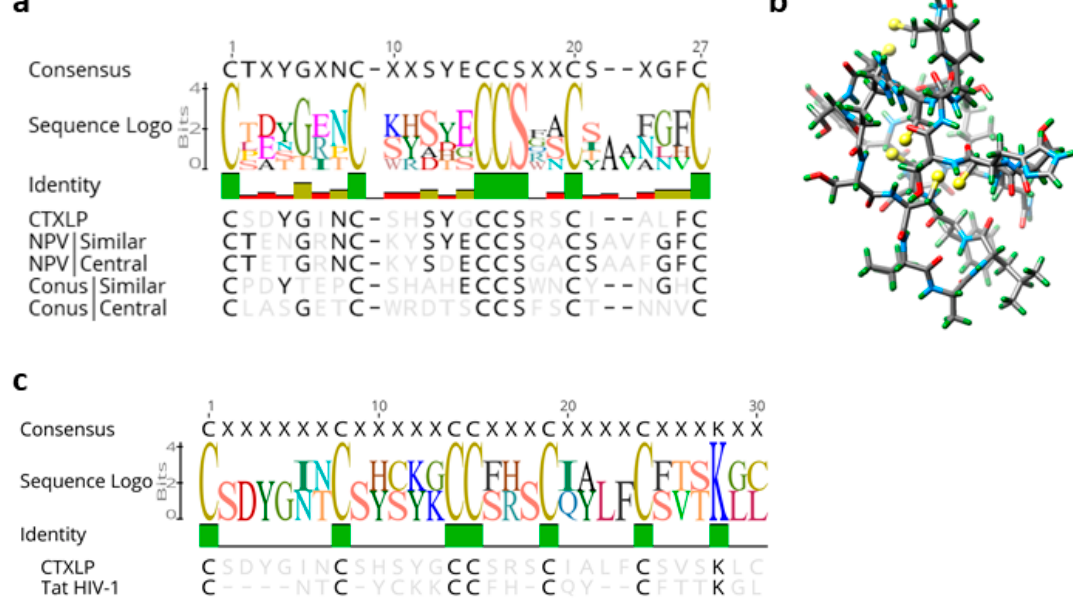
Figure 2. ERVK CTXLP is conserved structurally with Conus and viral conotoxins, as well as Human Immunodeficiency Virus (HIV) Tat. ( a ) ERVK CTXLP cysteine-rich motif has a strong similarity to both nuclear polyhedrosis virus (NPV, 46.2%) and Conus (45.8%) conotoxin proteins. Cysteine bridges conserved in knottin proteins are indicated with black bars. ( b ) A modeled 3D structure of the CTXLP domain was predicted using the Knotter1D3D software. Note the interactions of the yellow cysteine residues, as they form disulfide bonds. ( c ) Alignment and sequence logo of the cysteine-rich motif in ERVK CTXLP peptide and cysteine-rich domain of HIV-1 Tat protein. Conservation of six of the seven CTXLP cysteine residues is found in HIV Tat, as well as a C -terminal lysine